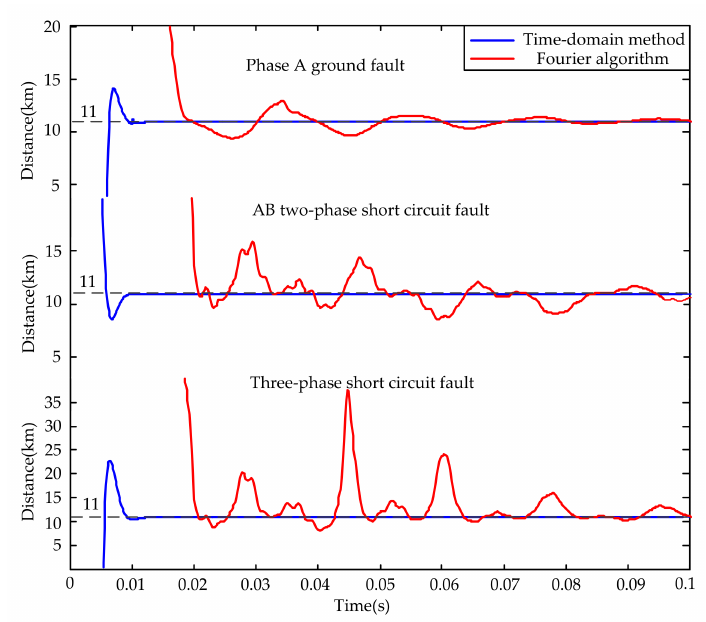
Figure 10. Comparison of two kinds of distance protection methods.